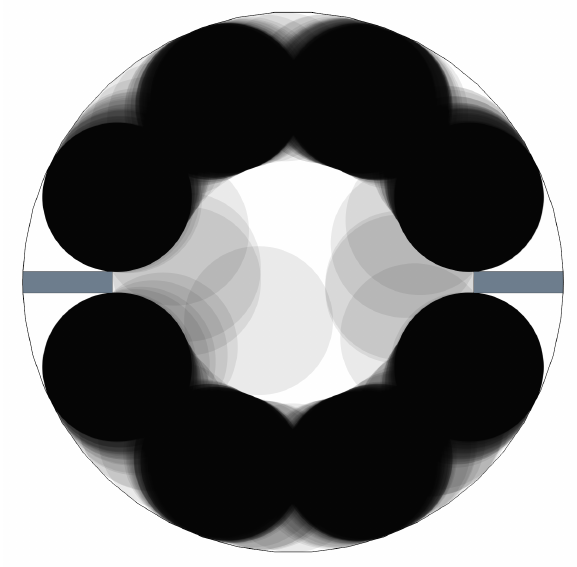
Figure 9. Transmitted light image of particles that have wall contacts (straight fin